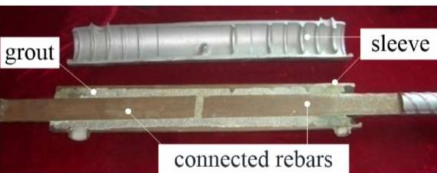
Figure 1. A cross section of a grouted sleeve splice of typical configuration to connect reinforcing steel bars.